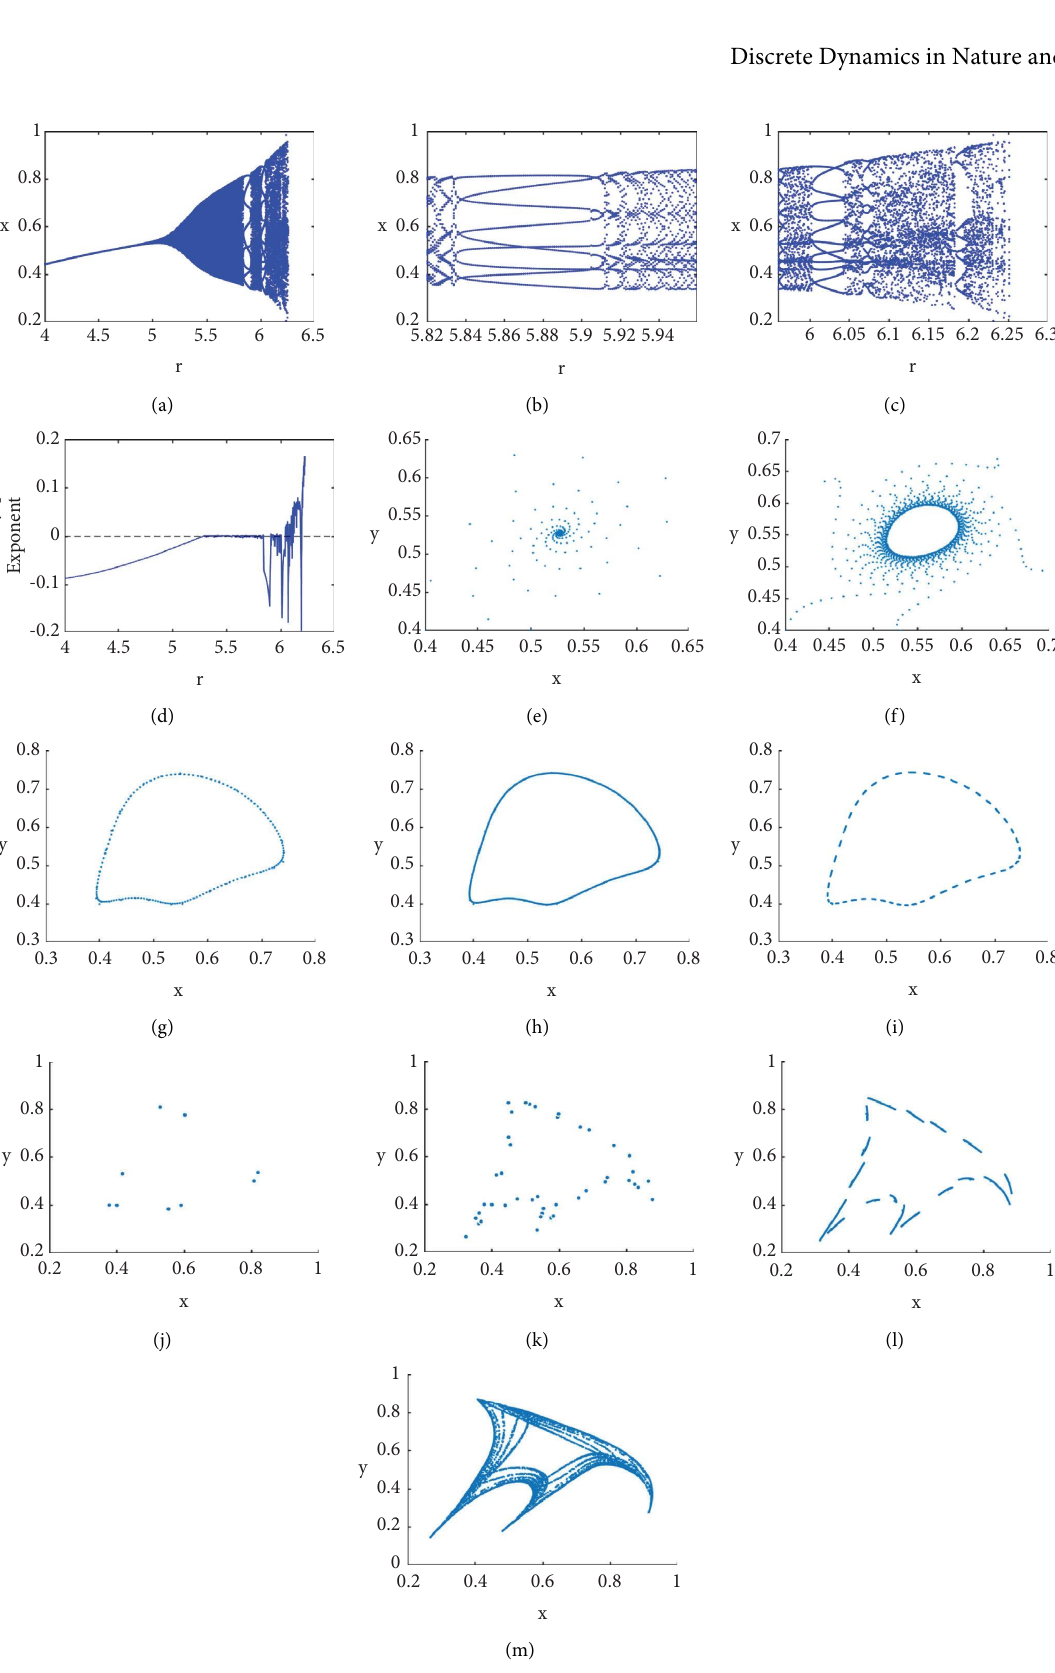
Figure 10: (a) Bifurcation diagram of the model (4) in ( r, x ) plane. (b) Local amplifcation for r ∈ ( 5 . 82 , 5 . 96 ) corresponding to (a). (c) Local amplifcation for r ∈ ( 5 . 96 , 6 . 3 ) corresponding to (a). (d) Maximum Lyapunov exponents corresponding to (a). Phase-plane diagrams for various values of r corresponding to Figure 9(a): (e) r � 4 . 9, (f) r � 5 . 291, (g) r � 5 . 5711, (h) r � 5 . 582, (i) r � 5 . 59, (j) r � 5 . 85, (k) r � 6 . 055, (l) r � 6 . 08, and (m) r � 6 .